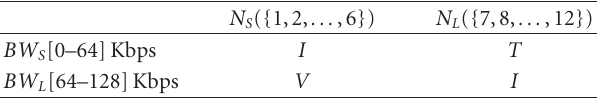
Table 2: Policy π ∗